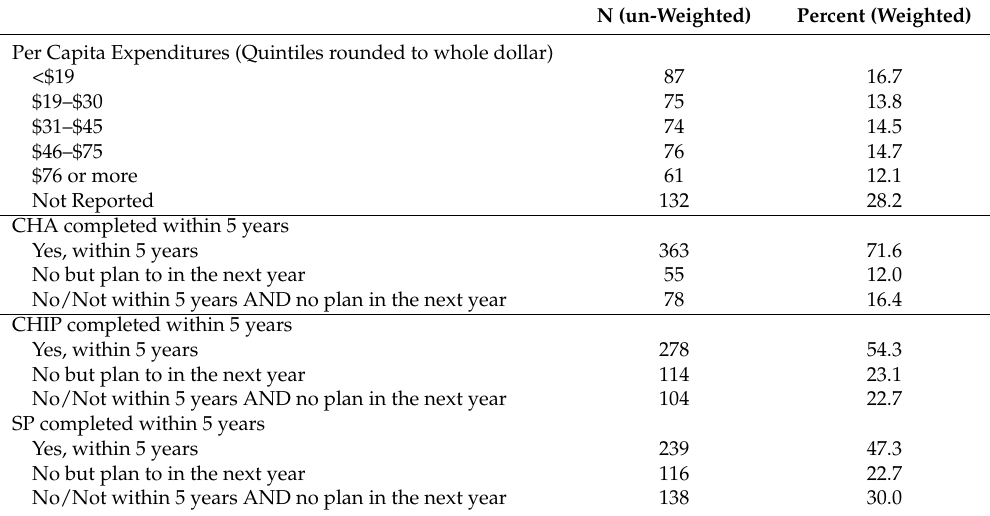
Table 1. Percent distribution of the LHDs in the sample by infrastructural, governance and other characteristics, 2013 National Profile of LHDs